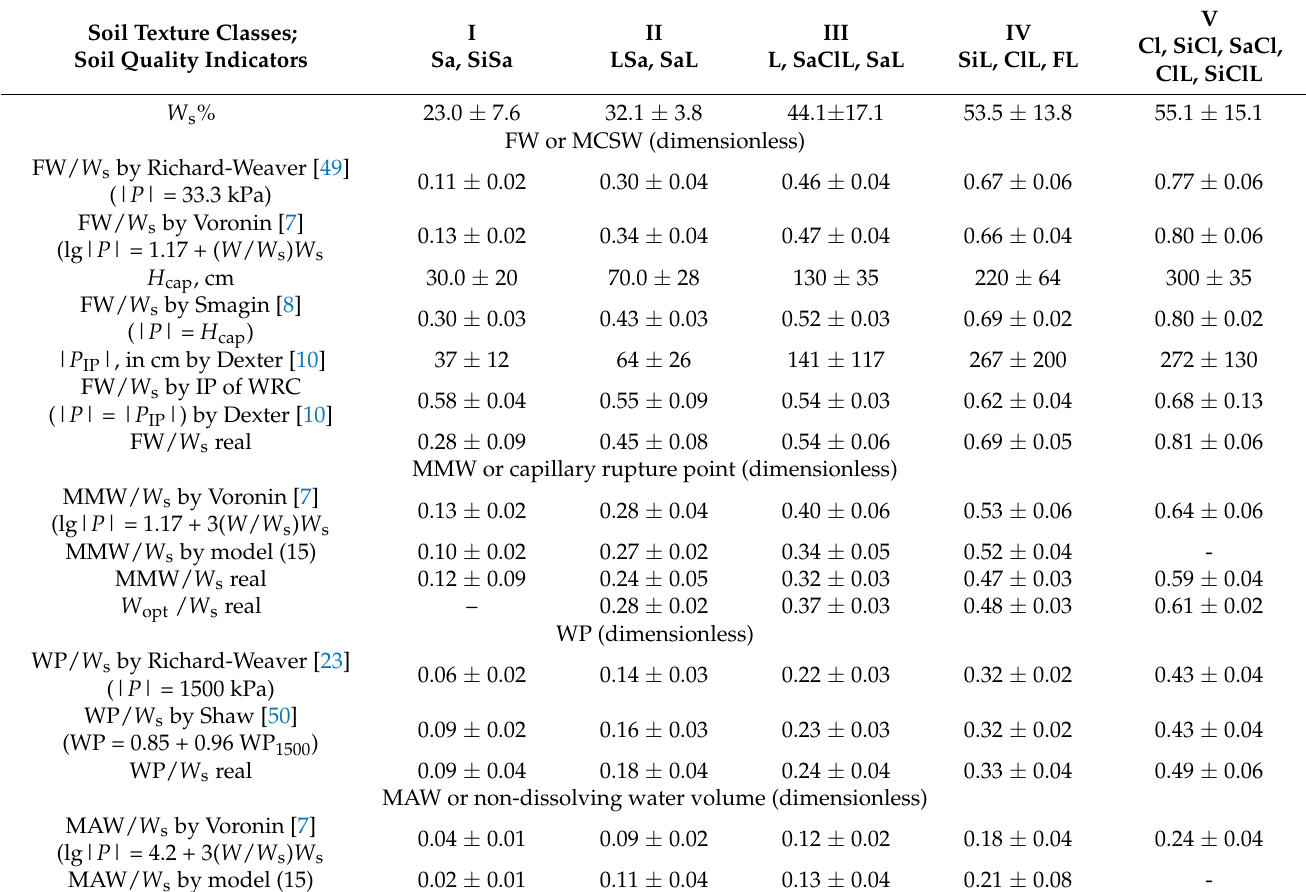
Table 2. Scaling indicators of physical quality for the main textural classes of Eurasian